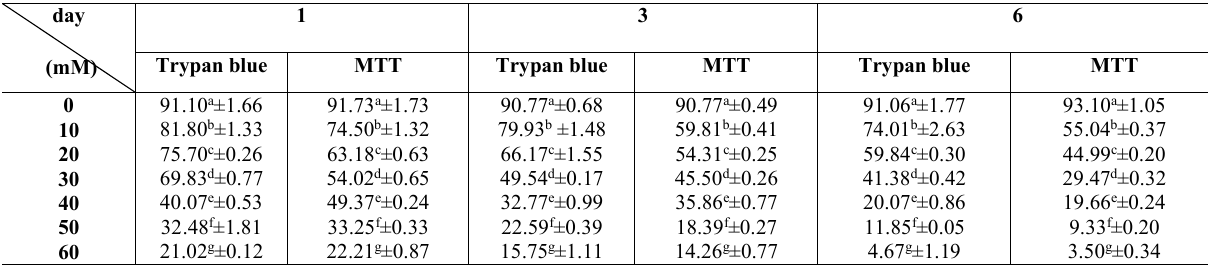
Table 1. Viability of the C. roseus callus cells after 1, 3 and 6 days of treatment with different concentrations of Cd(NO 3 ) 2 based on Trypan blue staining and MTT assay.